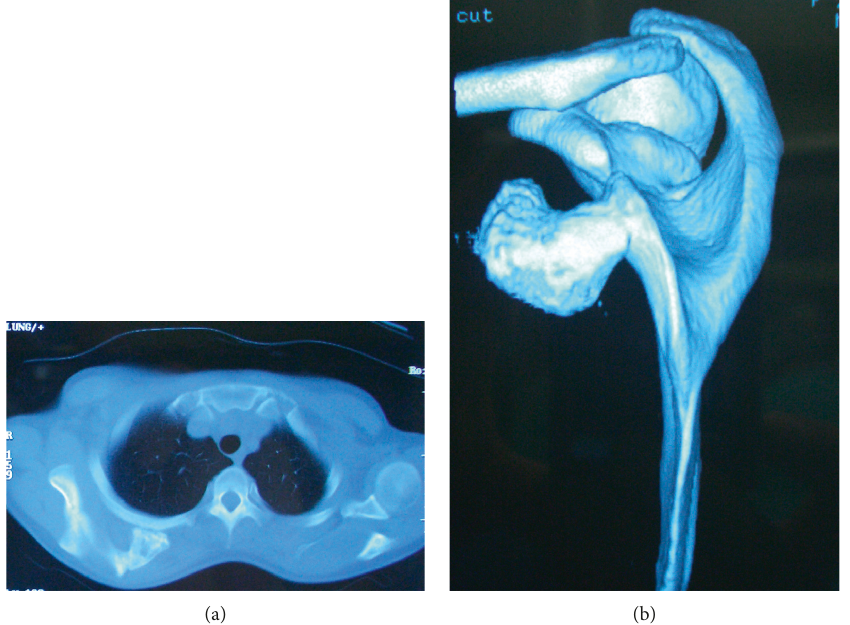
Figure 2: Preoperative computed tomography (CT) findings. (a) CT showed the mushroom-shaped osseous tumor composed of a cortex continuous with the scapular cortex, with a broad flat distal end that almost contacted the third rib. (b) Three-dimensional CTrevealed the close relationship between the base of the osseous tumor and the superomedial scapular